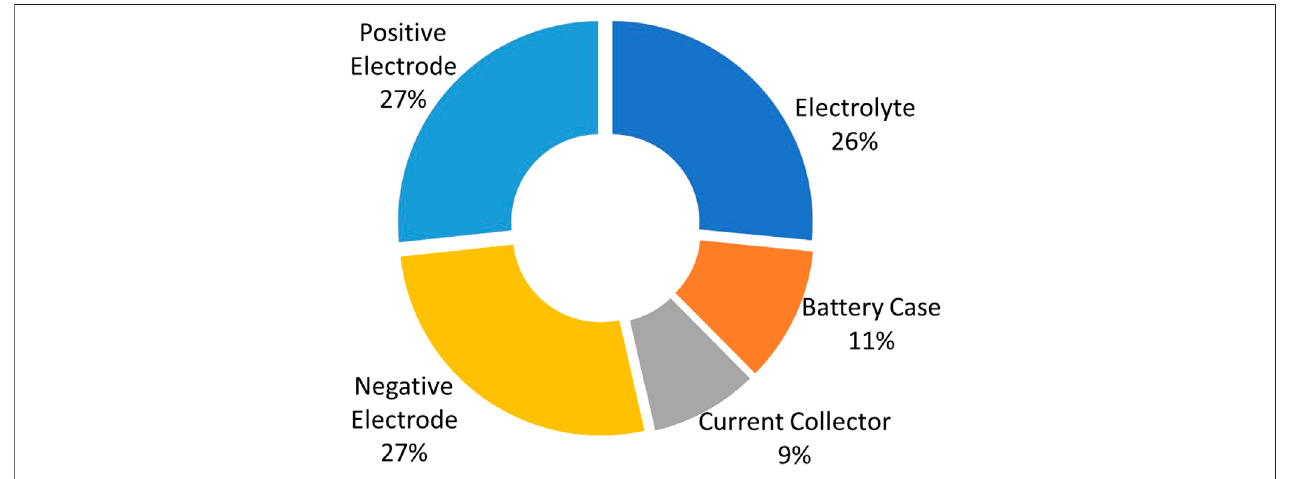
TABLE 1 | Geographical location of production and associated delivery distance to the United Kingdom for key components of the aqueous Al-ion cell. Material